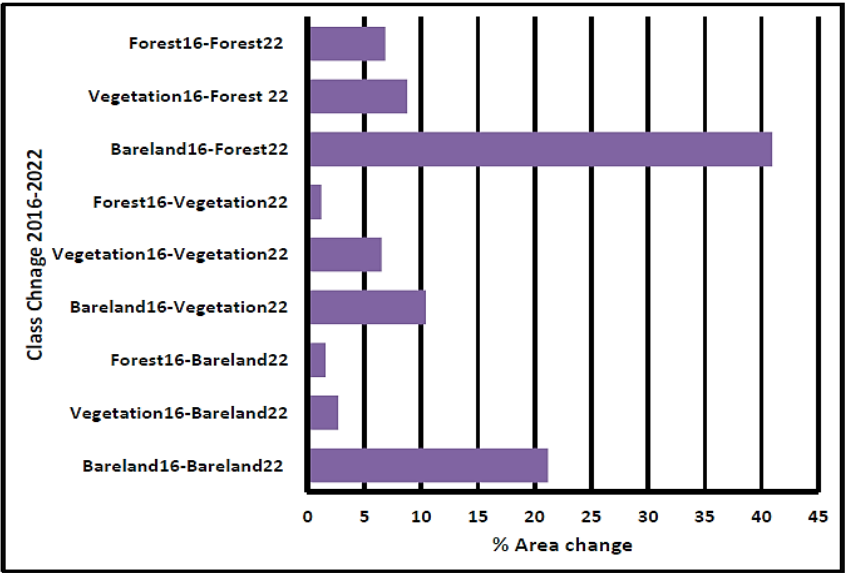
Figure 11. Cross classes % area calculated from the change map 2016–2022.